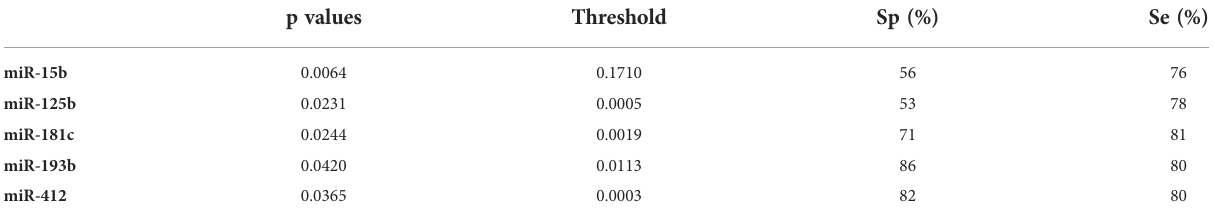
TABLE 4 Biomarker potential of 5 miRNAs.